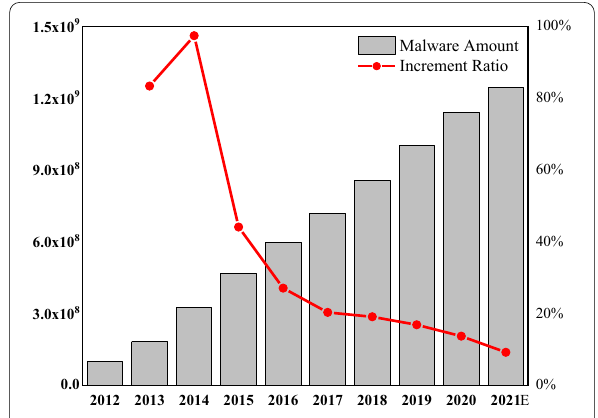
Fig. 1 The situation awareness of